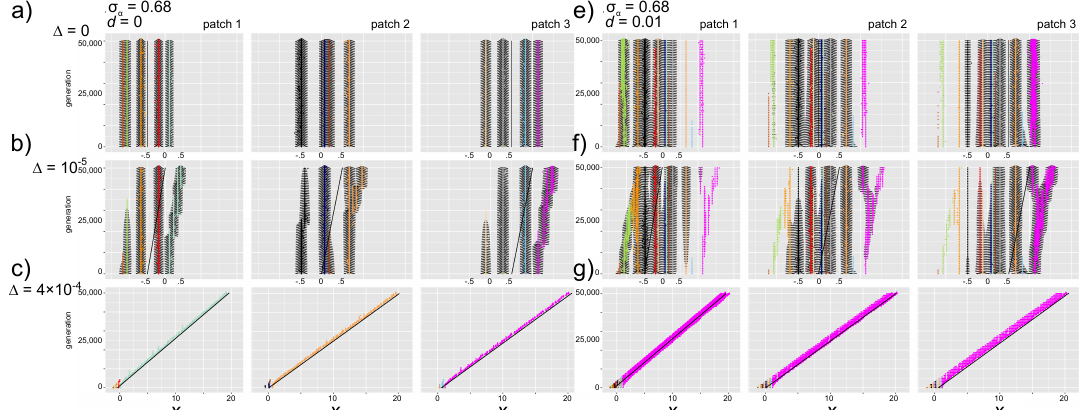
Figure 3. Trait distributions in communities over time across a range of environmental change rates with no and low dispersal. In all plots, σ α = 0.68, d = 0 or d = 0.01, and the rate of environmental change varies: ( a , e ) ∆ = 0, ( b , f ) ∆ = 10 − 5 , and ( c , g ) ∆ = 4 × 10 − 4 . The x axis range di ff ers for ( c , g ), as traits span a wider range (see Figure S4 to compare width of phenotypic distributions across all three rates of environmental change for d = 0). Communities in patches 1–3 are shown (from left to right) and features of the trait density plots are as described in Figure 2a (except that the time series are thinned to show every 800 generations and a relative minimum height of 0.05 is used). In ( b ), the species with the highest trait value in each patch is less constrained by competition than other species and experiences the most adaptive trait change. Species with lower trait values are gradually lost to extinction. In ( c ), all species are lost within 5000 generations and the species with the initially highest trait values persists and adapts over time. In ( f ), species can disperse to other patches and the species with the highest trait value in the entire metacommunity experiences the most adaptive trait change. The species in the metacommunity with the lowest trait value also experiences adaptive evolution and increased genetic diversity, but is eventually lost to